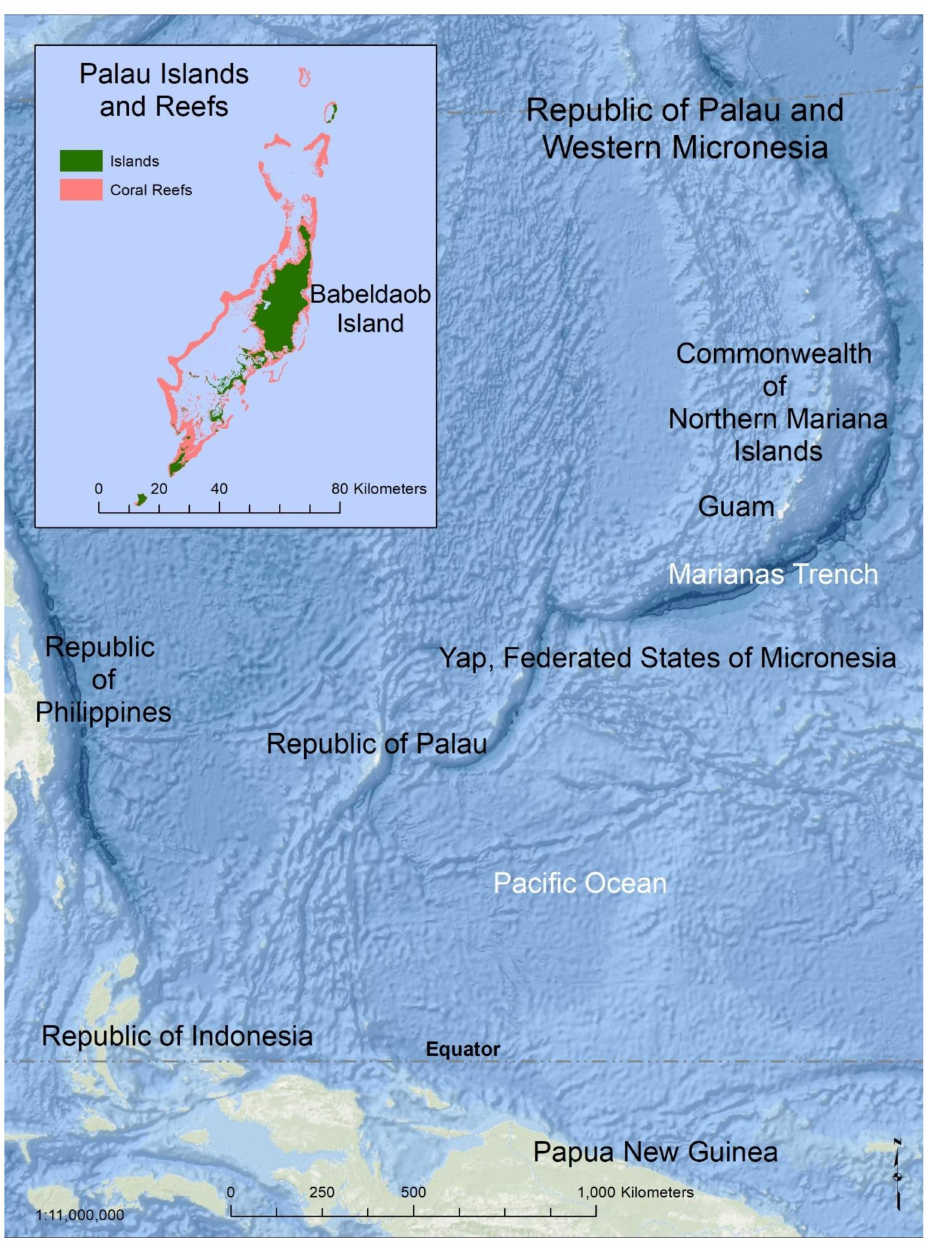
Figure 1. Location of the Republic of Palau and western Micronesia region within the Pacific Ocean. Our study site, the volcanic high island of Babeldaob, comprises ~365 sq. km (78%) of the total ~466 sq. km of Palau’s land area, contains ten states, and is home to about 5000 human residents, representing 30% of the nation’s population [30]. The island has a rolling, rugged landscape, and at least 46 km 2 of the terrain has been shaped into immense earth architecture over three millennia of human history [31]. Wildfires appear to have arrived in Palau with early inhabitants, at least 3000 years ago, as indicated by the appearance in paleo records of charcoal, taro, and increases in various grasses